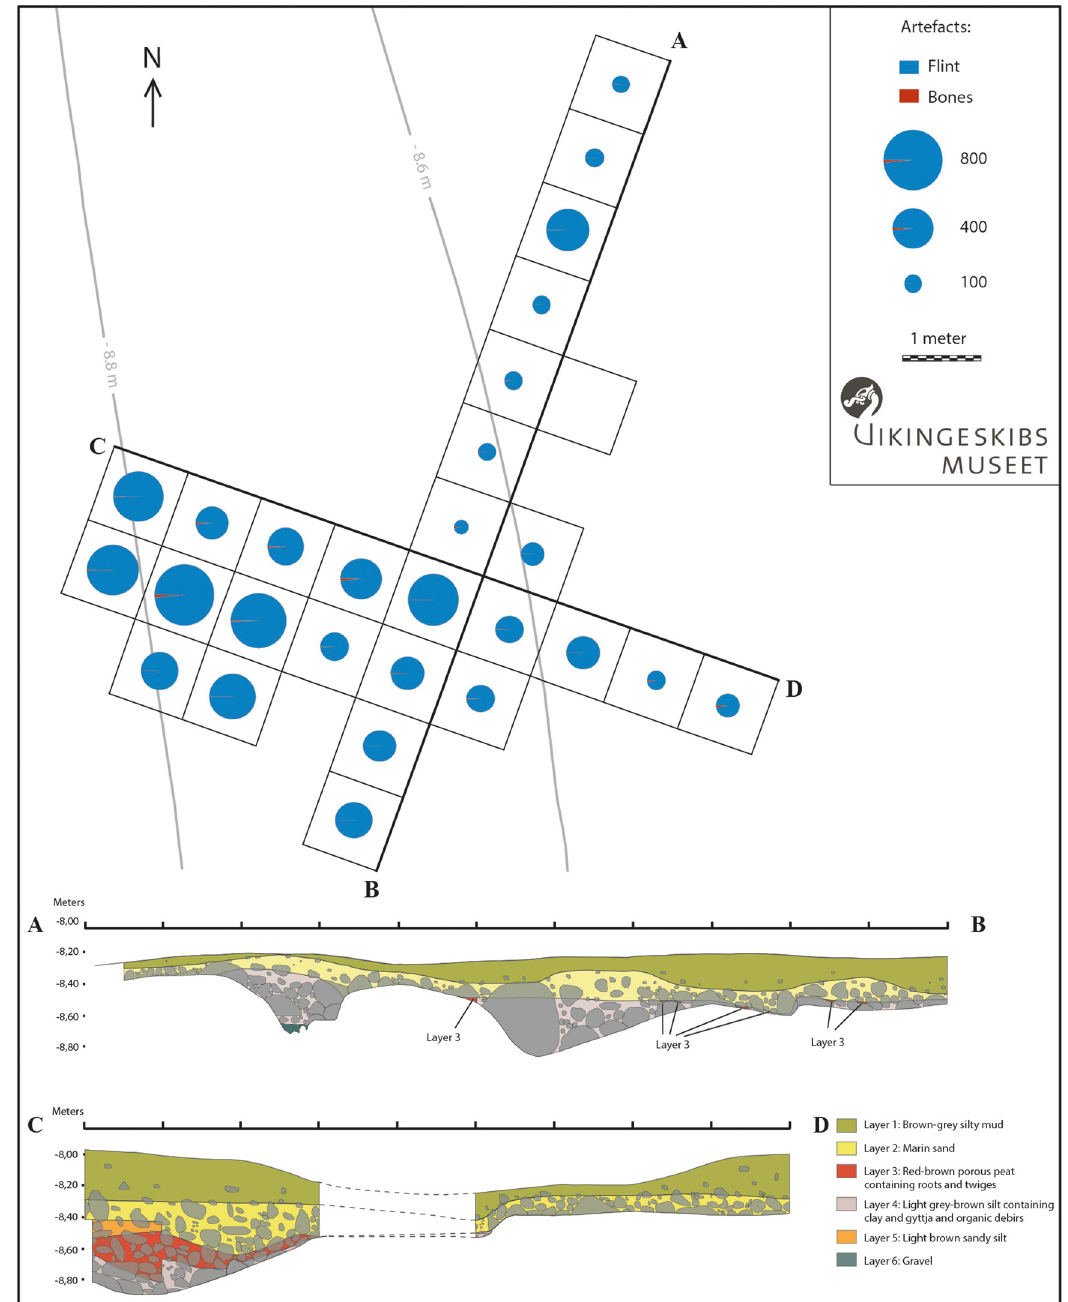
Figure 3: Vordingborg Vesthavn , site plan and pro fi les. Contour lines represent the depth of the